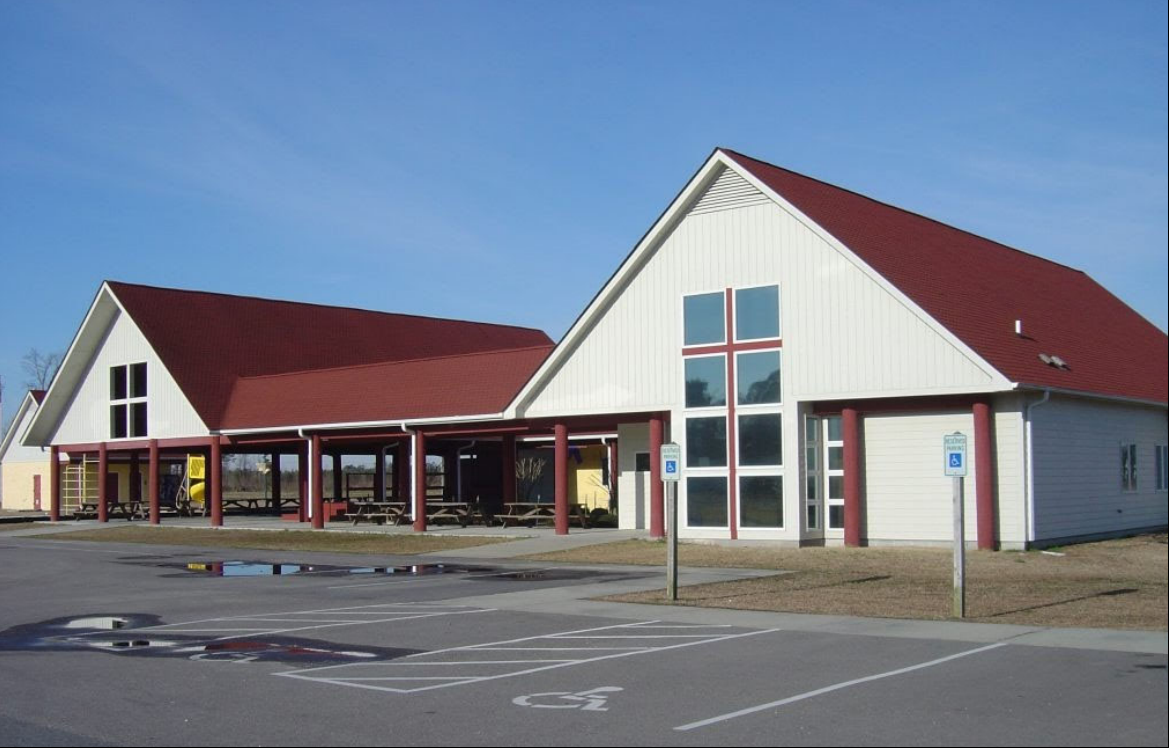
Photo courtesy of Episcopal Farmworker